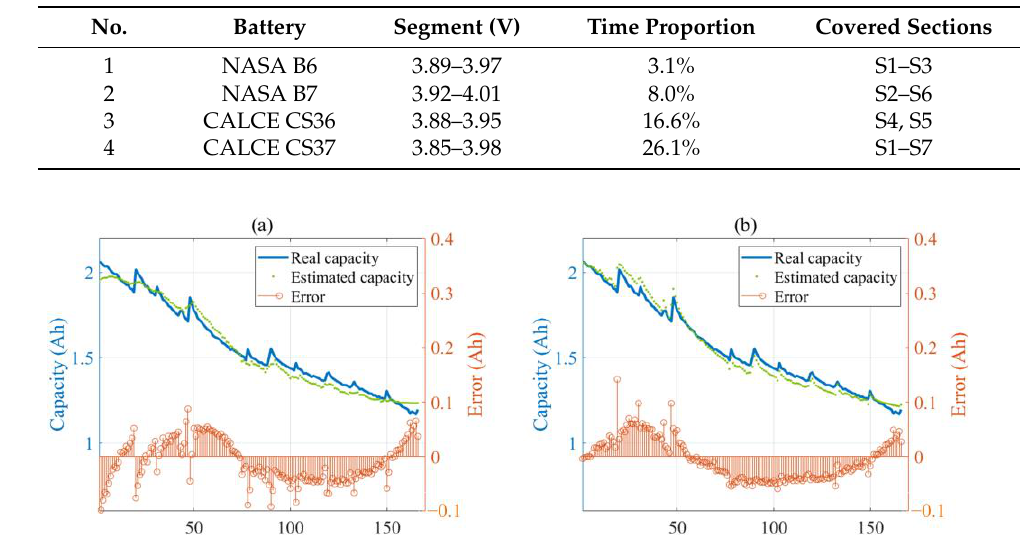
Table 6. The details of four selected voltage segments.